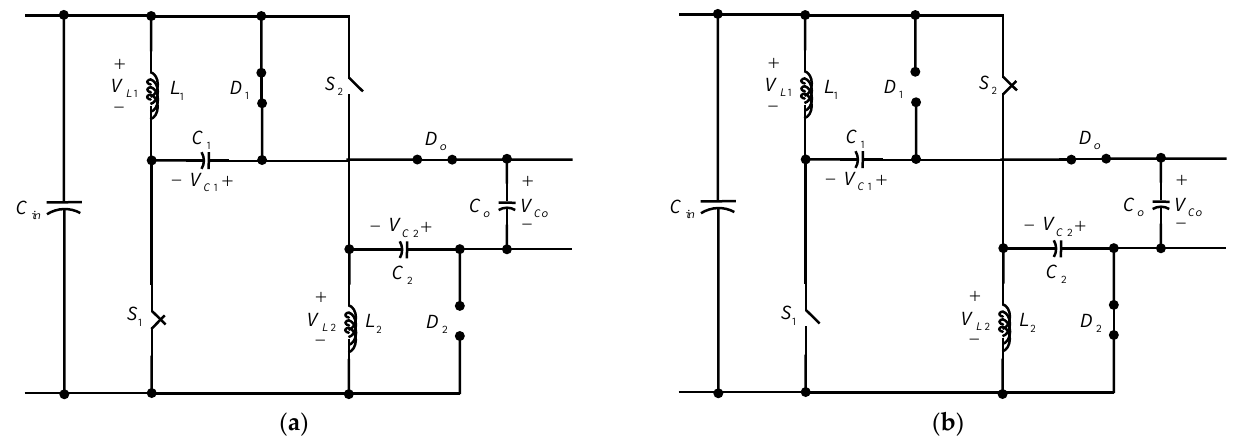
Figure 2. The equivalent circuit of the proposed topology in CCM; ( a ) at T on , ( b ) at T of f . This time interval of T of f begins when the switch of S 1 is turned off and the switch of S 2 is turned on. In this situation, the diodes of D 2 and D o are turned on and the diode of D 1 is turned off. So, the inductor L 2 is connected to V i ; therefore, its stored energy is increased. Additionally, the stored energy of the capacitor C o is increased, then it is charged. The equivalent circuit of the proposed topology is shown in Figure 2b. Some key waveforms of the proposed topology in CCM are illustrated in Figure